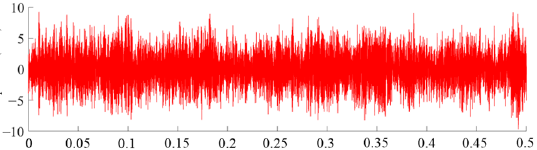
Figure 3. Time domain waveform of vibration signal of main pump in rotor system abnormal state.